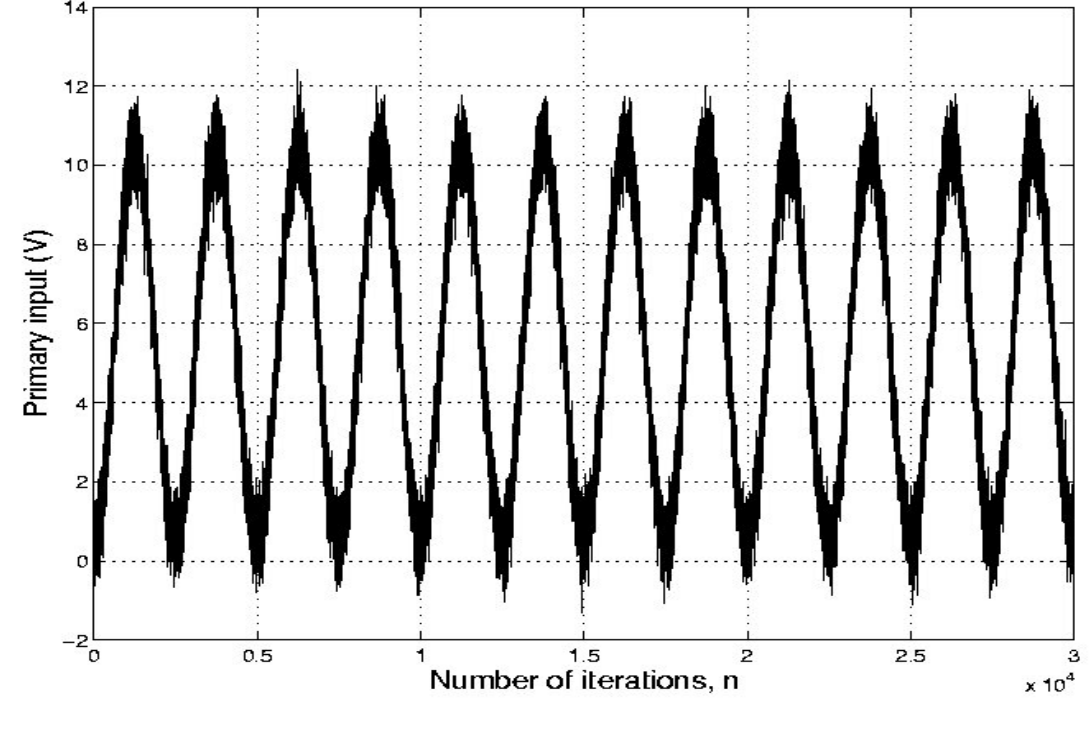
Figure 4. A typical signal coming from the sensor versus n (1V = 4.5 0